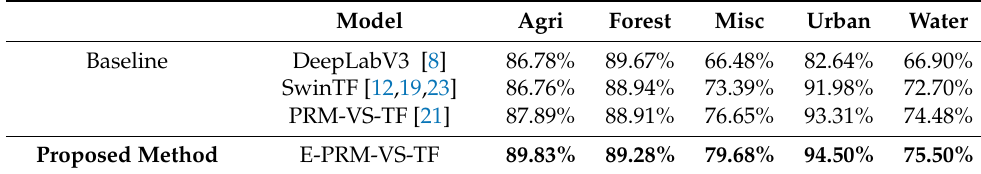
Table 2. Effects on the testing dataset of the Thailand Landsat-8 challenge for each class with the proposed procedures in terms of AverageAccuracy